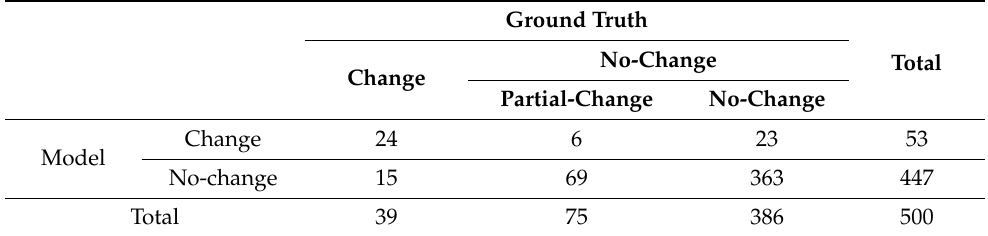
Table 3. Contingency table of model and ground truth data for the period of 2006–2015.